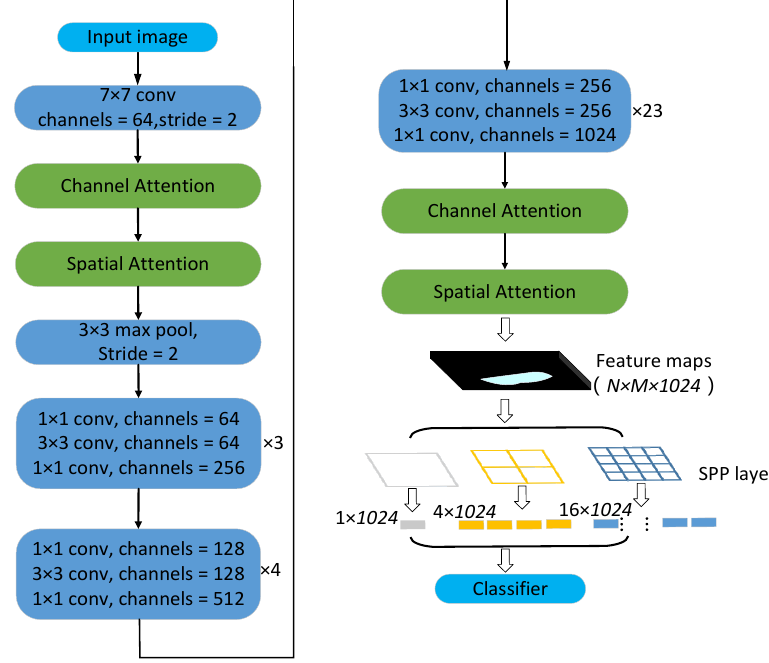
Figure 7. AM-SPPResNet Structure Graph for Feature Extraction.